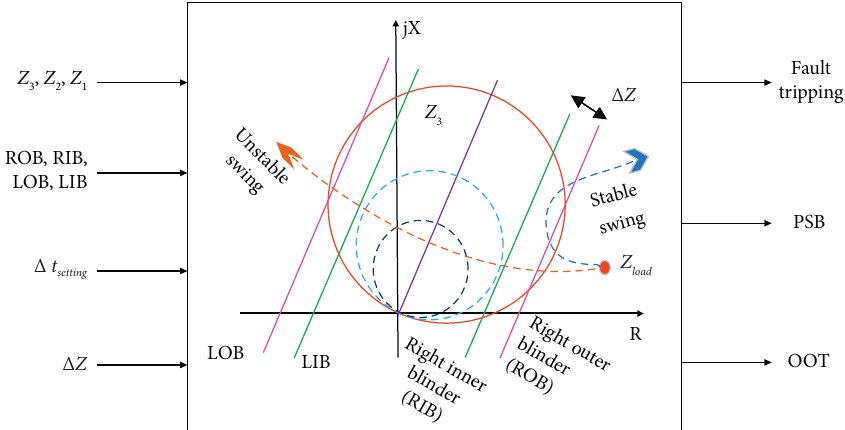
Figure 2: PMU input and output.